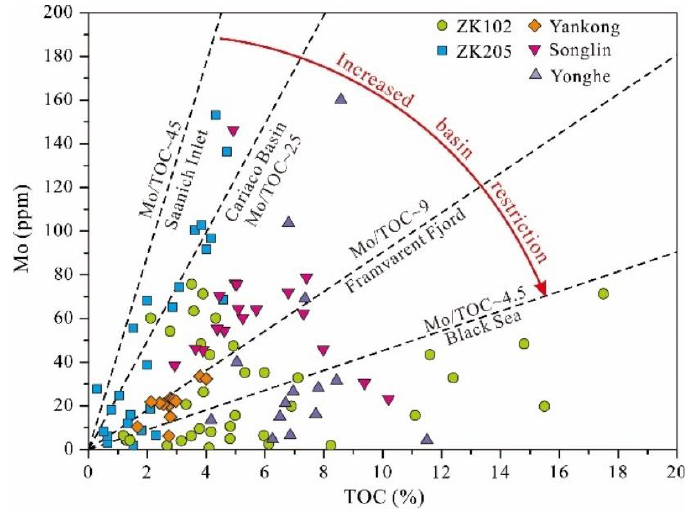
Figure 12. Plots of TOC versus Mo (modified from